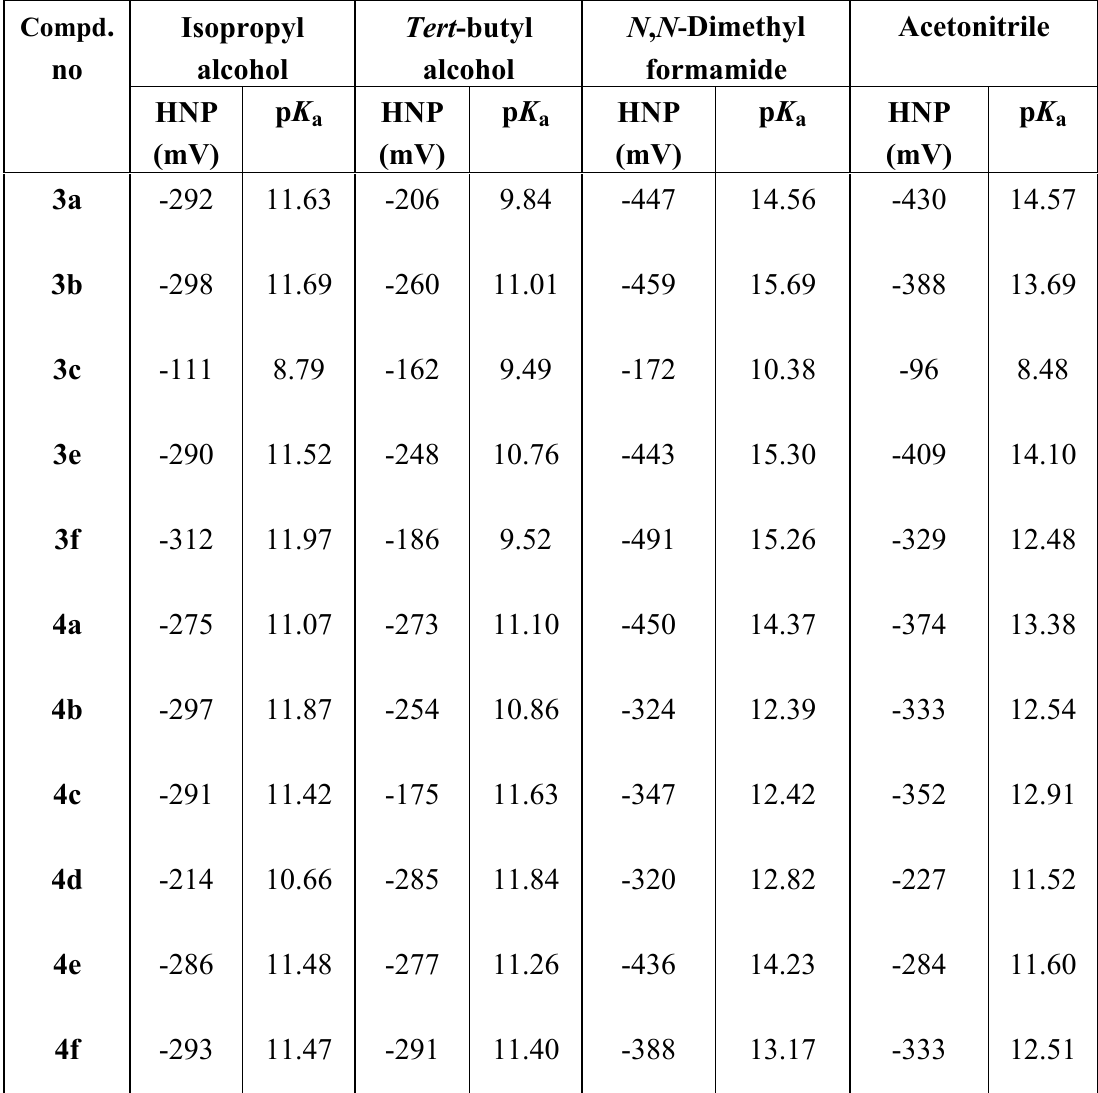
Table 1. The half-neutralization potentials (HNP) and the corresponding p K compounds 3 and 4 in isopropyl alcohol, tert- butyl alcohol, N , N -dimethylformamide and